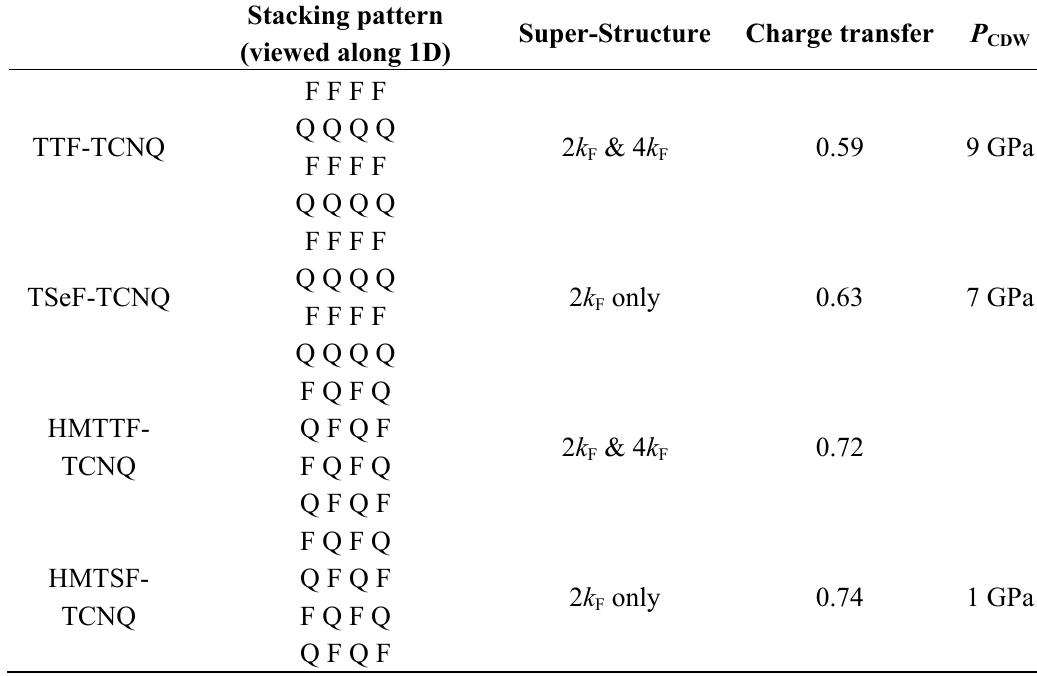
Table 1. Comparison of four TTF-TCNQ analogues in terms of stacking pattern viewed along 1D axis, superstructures of 2 k the pressure, where CDW is